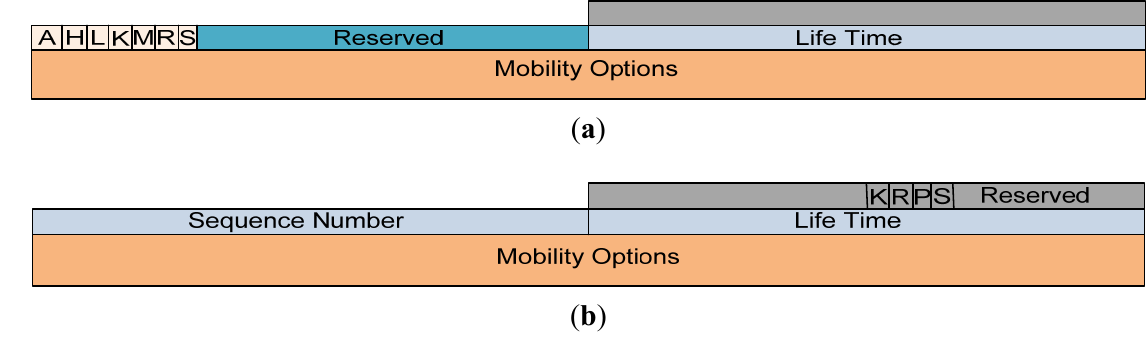
Figure 11. ( a ) PBU Message Format; ( b ) PBA Message Format .